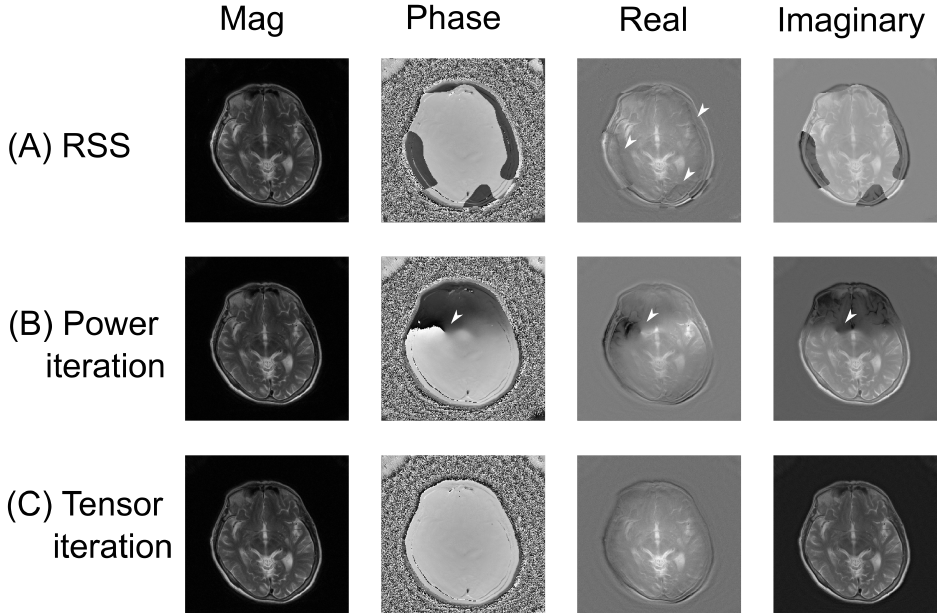
Figure 3. In vivo study for the least-squares reconstructed images using different coil sensitivity estimation methods. White arrow heads indicate the phase singularities in the phase image, which led to local changes of intensity in the real and the imaginary components; ( A ) RSS: images reconstructed by RSS coil sensitivities; ( B ) Power iteration: images reconstructed by the coil sensitivities of the power iterations, which were influenced by phase singularities; ( C ) Tensor iteration: images reconstructed by the coil sensitivities of the tensor iterations, which were more homogeneous than the results of ( B